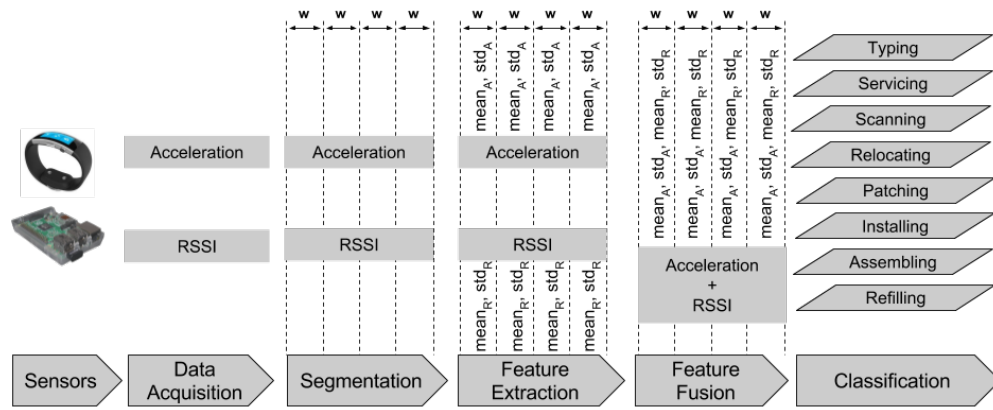
Figure 4. Overview of the activity recognition chain implemented in our